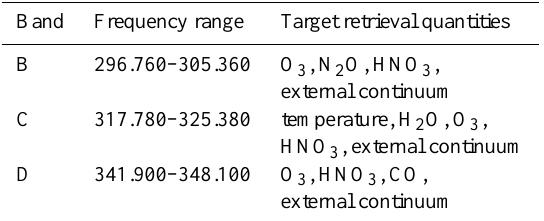
Table 2. Frequency range and retrieval targets of the three MARSCHALS bands. The frequency ranges of the MARSCHALS bands reported in the table, used for the PrEx1 data analysis, follow the updated instrument